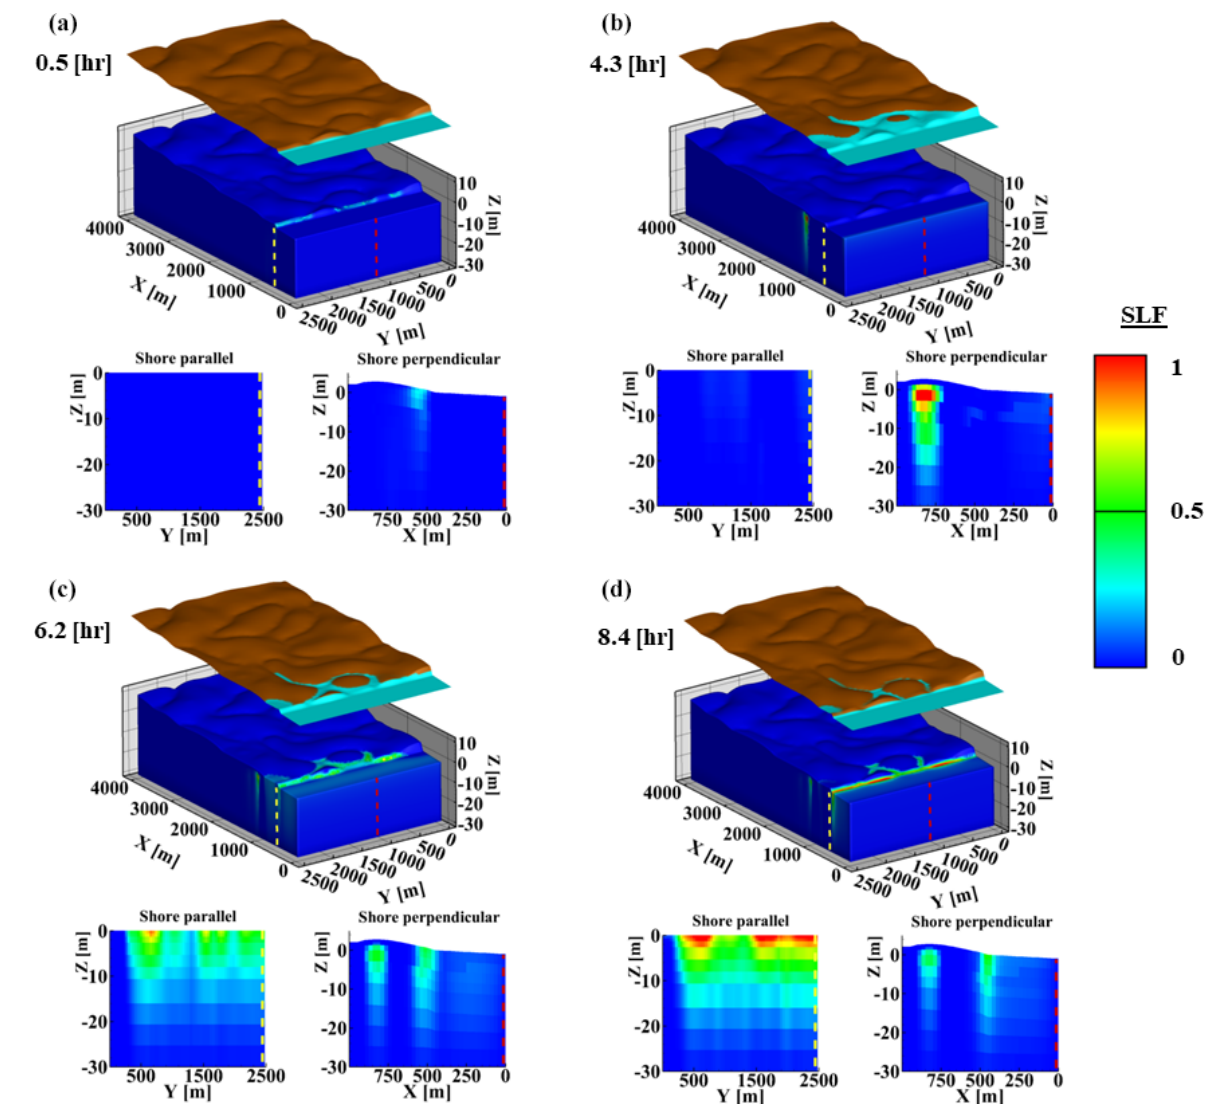
Figure 4. Surface flooding and vertical hydraulic gradients at (a) 0.5, (b) 4.3, (c) 6.2, and (d) 8.4h after the simulated surge begins. In each panel, the surface domain is shown on top, the subsurface three-dimensional domain and vertical gradients are shown below, and the two cross sections through the subsurface are shown: shore-parallel (left in each panel) and shore-perpendicular (right). The locations of the sections are shown on the three-dimensional plot as red dashed lines (for shore-perpendicular) and yellow dashed lines (for shore-parallel). Panels (a, b) are during the run-up stage and panels (c, d) are during the retreat stage. Refer to Fig. 2 for the surge height at each time shown here. Note that downward gradients (head increases downward) are plotted as positive values of SLF and upward gradients (head increases upward) are plotted as zero